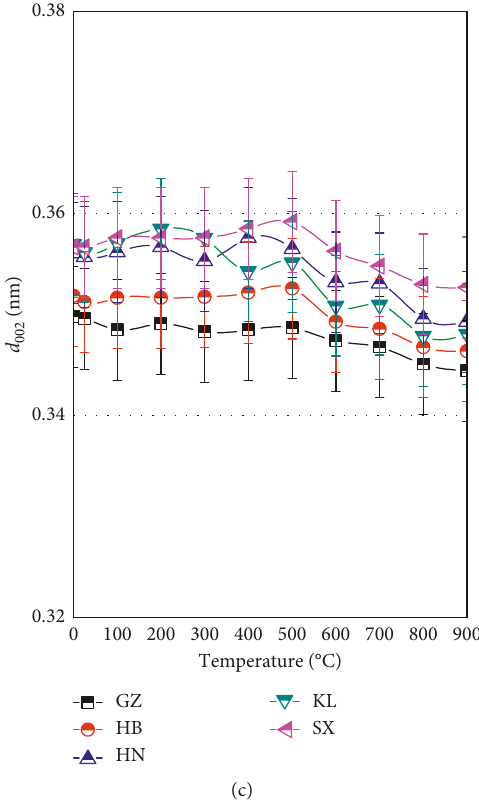
Figure 9: Variation of XRD structural parameters with